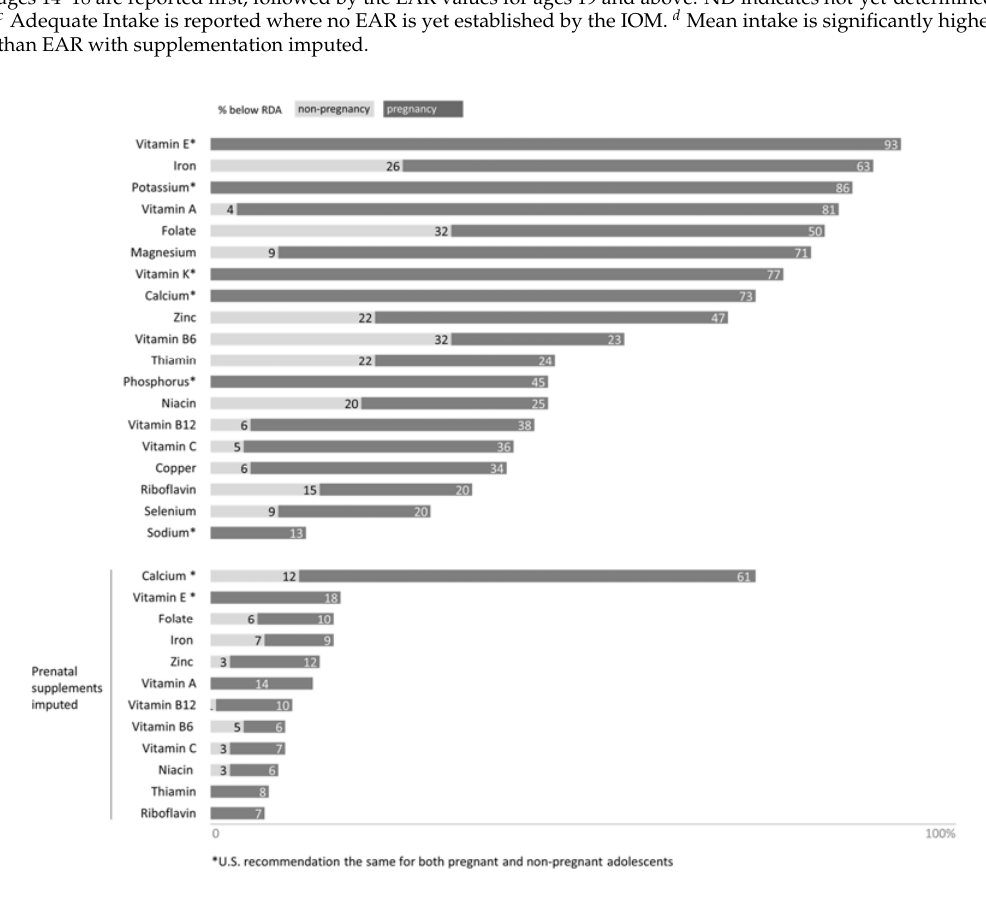
Figure 1. Micronutrient Intake of 108 pregnant Latina adolescents measured with a 24-hour food recall during the 2nd trimester of gestation and compared to the Recommended Dietary Allowance (RDA) for pregnant and non-pregnant adolescents. Figure legend: The bars represent the percentage of participants below the Recommended Dietary Allowance (RDA) for pregnant and non-pregnant adolescents. The proportion in dark grey represents the percentage of participants who do not meet the RDA for adolescent pregnancy (in addition to non-pregnancy), and the proportion in light grey represents the percentage of participants who do not meet the RDA for adolescents only.